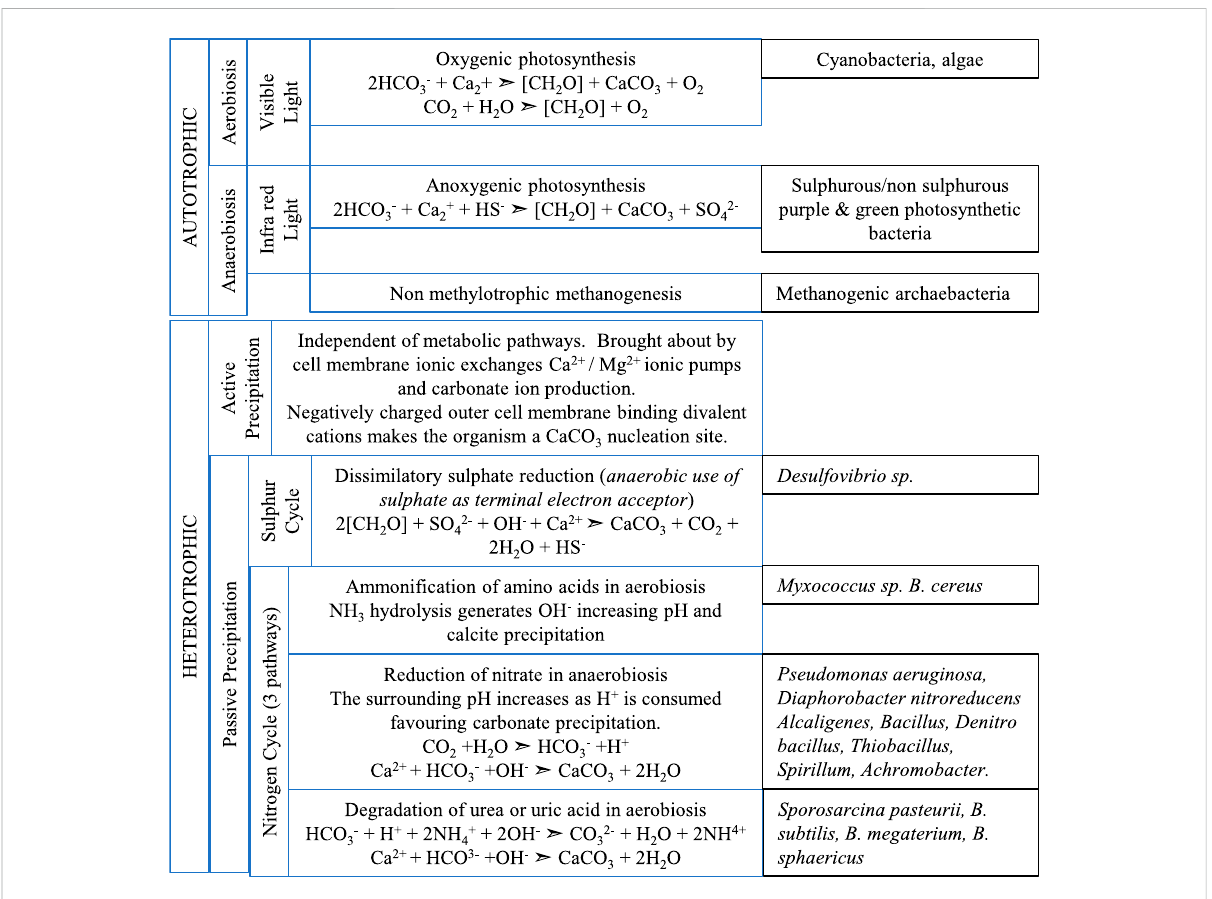
FIGURE 2 Comparison between autotrophic and heterotrophic bacterial production of CaCO 3 . A redox generated high environmental pH is common across metabolic pathways. Autotrophic bacteria: Aerobiosis (Duprazand Visscher, 2005),Anaerobiosis(Baumgartner etal., 2006;Reeburgh, 2007), Heterotrophicbacteria: ActivePrecipitation(Stocks-Fischer,GalinatandBang,1999),Passive precipitation(sulphur cycle)(Baumgartneretal.,2006; Braissant et al., 2007), (nitrogen cycle pathways) (Lee, 2003; Rodriguez-Navarro et al., 2003; Kavazanjian and Karatas, 2008; González-Muñoz et al., 2010; Jroundi et al., 2010; Achal and Mukherjee, 2015; Er ş an, de Belie and Boon, 2015; Wei et al., 2015).